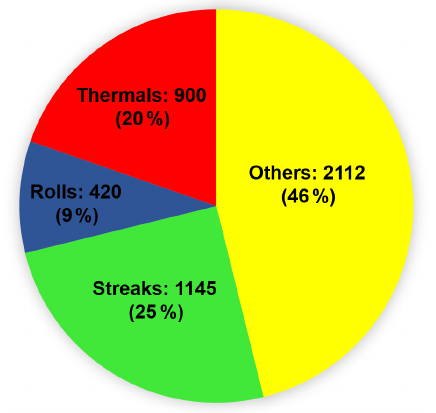
Figure 9. Classification of the whole ensemble using the QDA method according to the parameters of Fig.